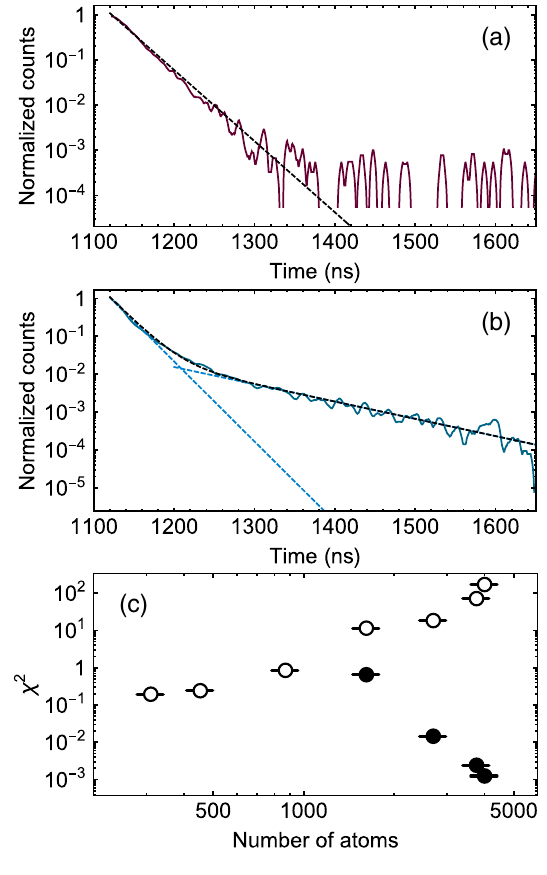
FIG. 7. (a) Solid line: example of decay in the small-atom- number regime ( N ≃ 300 ) shown with the fit using a single exponential decay (dashed line). (b) Solid line: decay in the large- atom-number regime ( N ≃ 4000 ), dashed line: phenomenological fit with the sum of two exponential decays. The dotted lines represent the two different decay rates, i.e., super- and subra- diance. The traces in panels (a) and (b) have been normalized to the steady state. (c) Values of χ 2 obtained with the double- exponential (filled circles) or a single-exponential decay (empty markers) versus atom